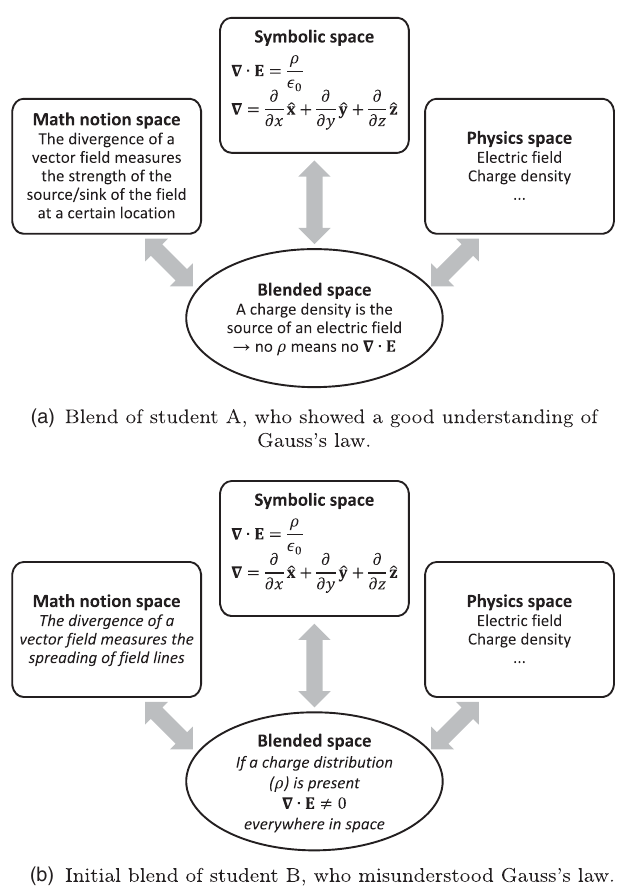
FIG. 5. Examples of blends concerning the understanding of the divergence of an electric